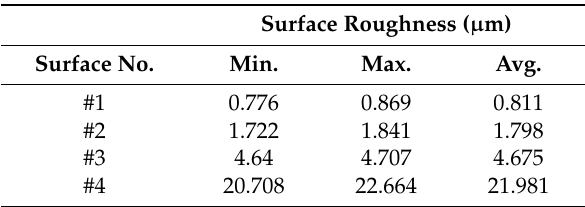
Table 3. Surface roughness measured using optical profilometry.